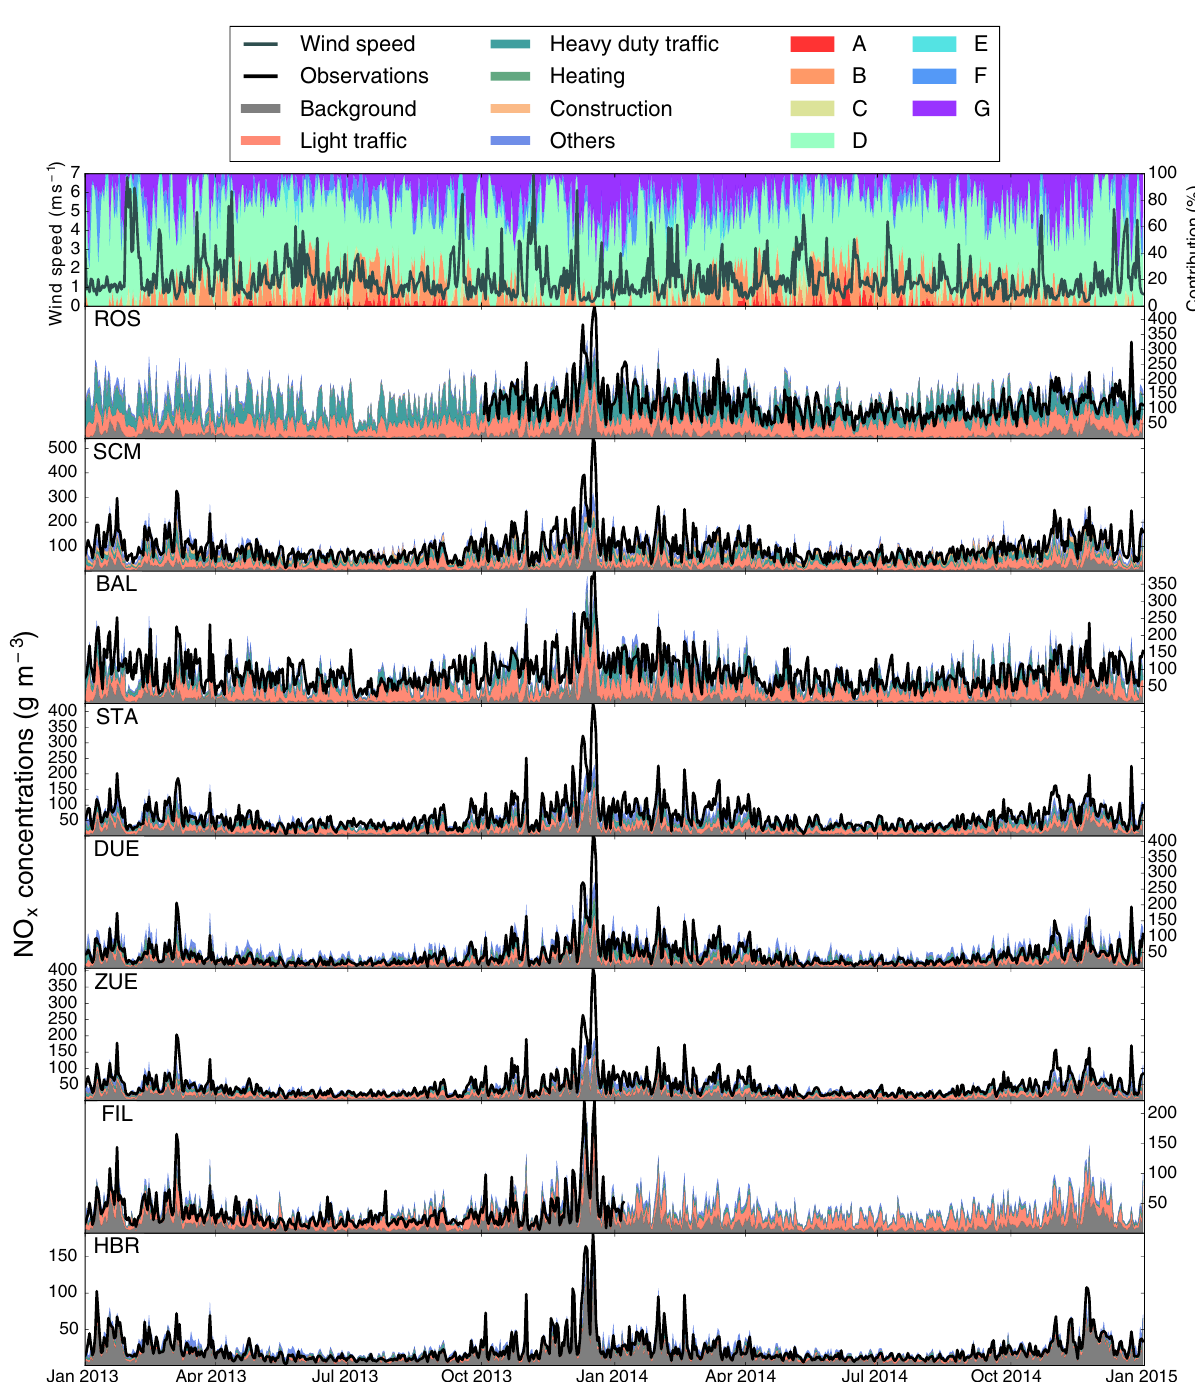
Figure 5. Daily observed and simulated concentrations at all observation sites for the years 2013 and 2014. Simulations are separated by contributions as in Fig. 4. Top: daily averages of stability class contributions (A–G) and wind categories. Measurements at FIL were discontinued in January 2014, whereas the site ROS started being operated in October